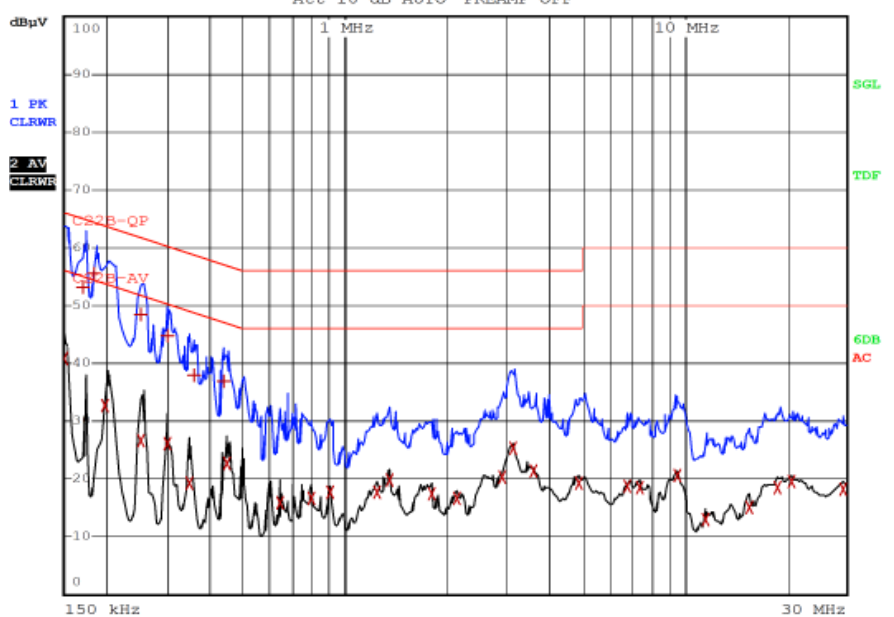
Figure 13. Conducted Emission for EUT—Null wire: average values—black waveform, quasi-peak values—blue waveform.